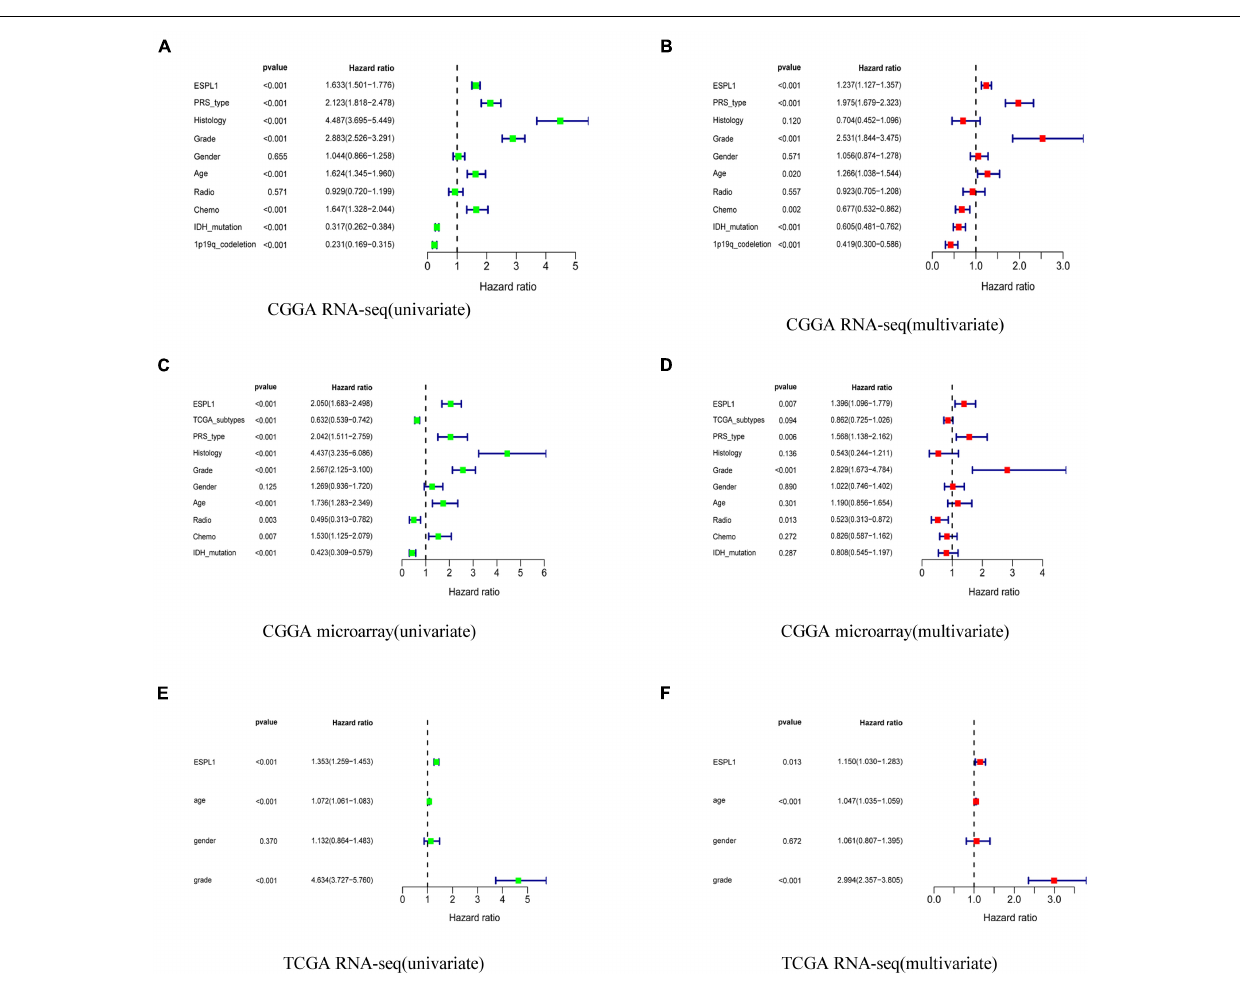
Frontiers in Genetics |